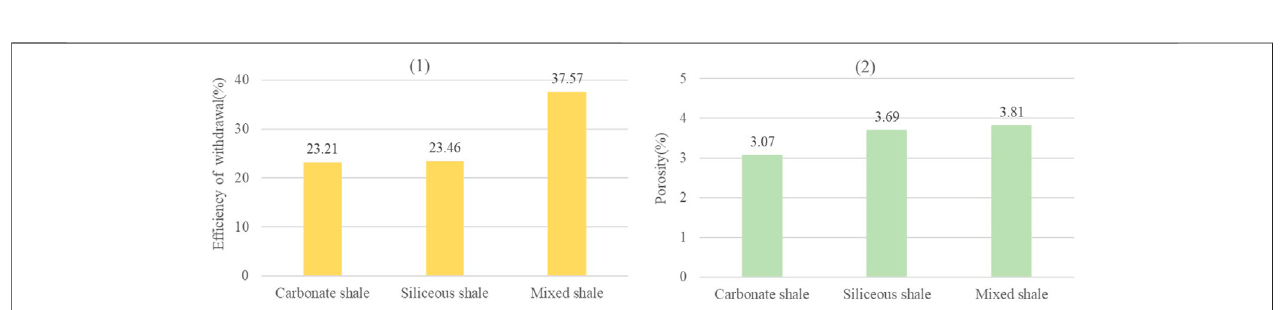
FIGURE 8 | Comparison of the ef fi ciency of mercury withdrawal and porosity in different mineral composition.